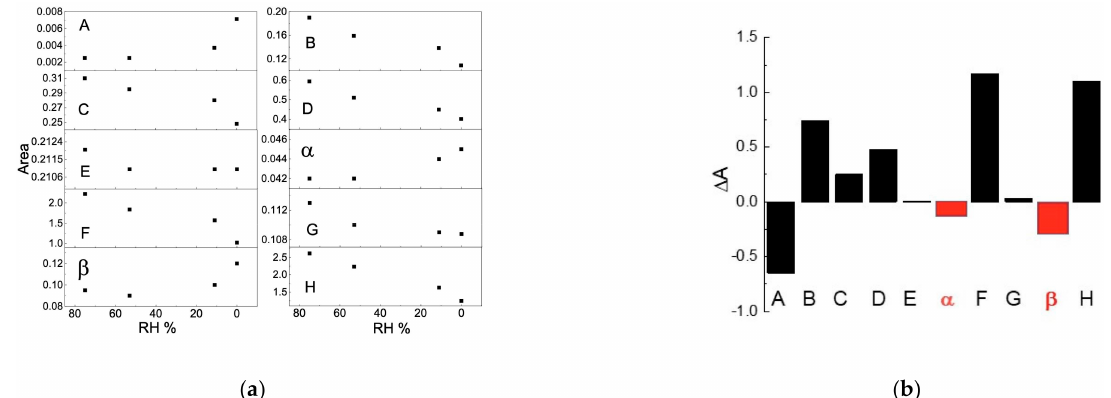
Figure 5. DMPC/H 2 O samples. ( a ) Dependence of the areas of the eight Gaussian band components on the relative humidity. Each panel corresponds to a different band, as named in Table 2. ( b ) Percentage variation of the area of each band in the dry state with respect to the wet state (RH =